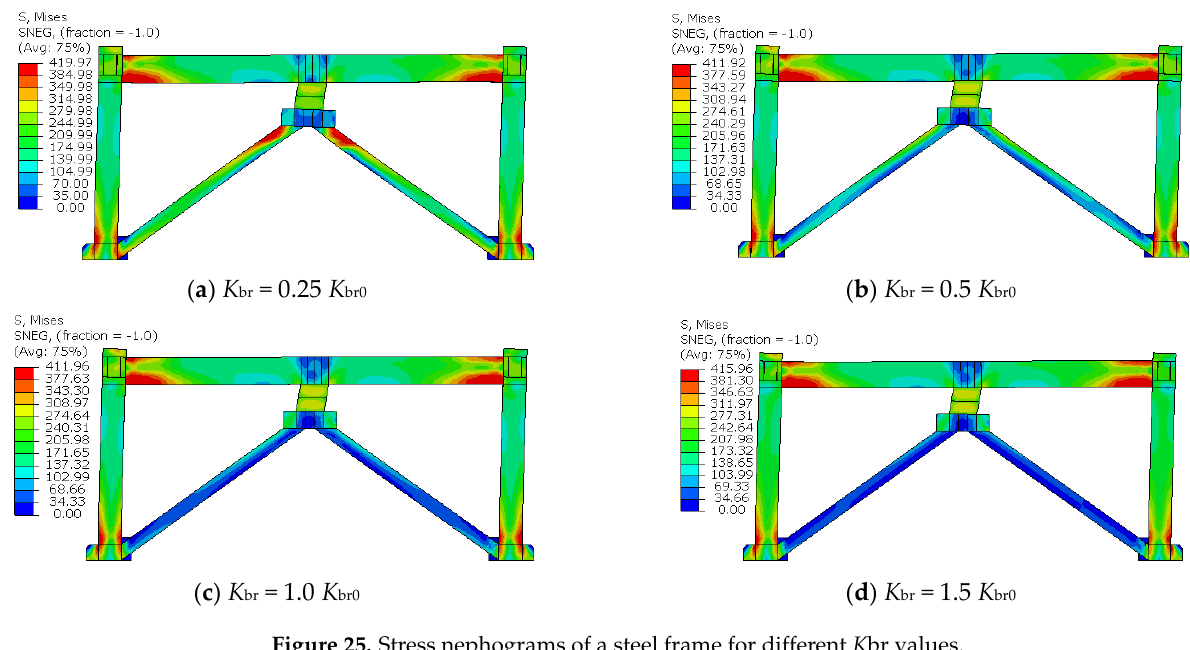
Figure 25. Stress nephograms of a steel frame for different K br values.